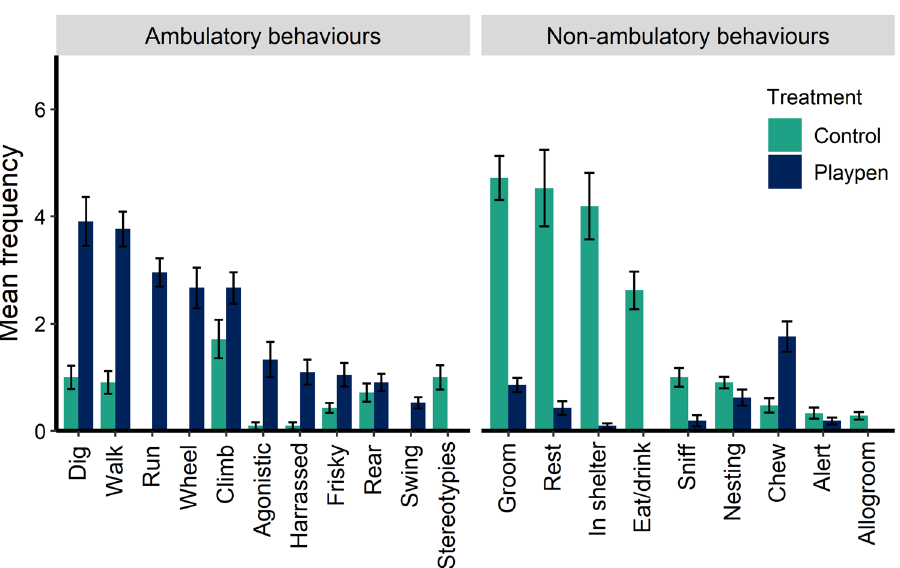
Figure 4. Mean (± SE) frequency of each behaviour observed during scan sampling. Behaviours are divided into the overall categories of ambulatory and non-ambulatory activity. Mice were observed 5 times per day for 5 d for a total of 25 scans per mouse; n = 42 mice, with 7 cages per